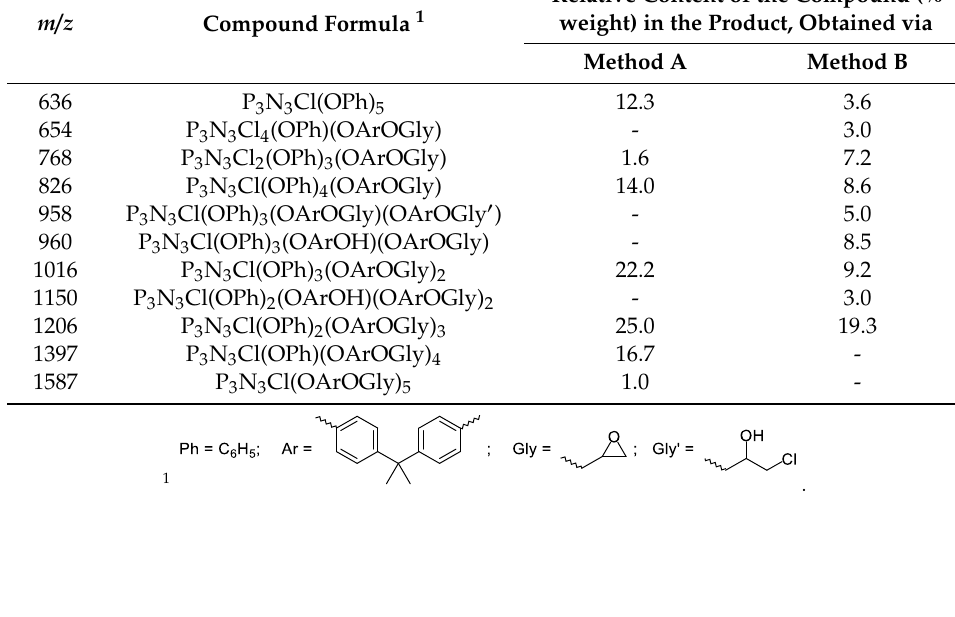
Table 2. Results of chromatography-mass spectrometric analysis of organic fractions of reaction products obtained according to schemes A and B. Molar ratio of HCP:phenol:bisphenol A = 1:3:5. Chromatography Data (Figure 6) Mass-Spectrometric Data (Figure Figure 5. MALDI-TOF mass spectra of epoxycyclophosphazenes synthesized according to schemes A ( a ) and B ( b ) at molar ratios of HCP: phenol: bisphenol A = 1:3:5. Table 1. The content of the phosphazene fractions of products synthesized by schemes A and B according to the data of MALDI-TOF-spectrometry. The molar ratio of HCP: phenol: bisphenol A = 1:3:5. Relative Content of the Compound (% m / z Compound Formula 1